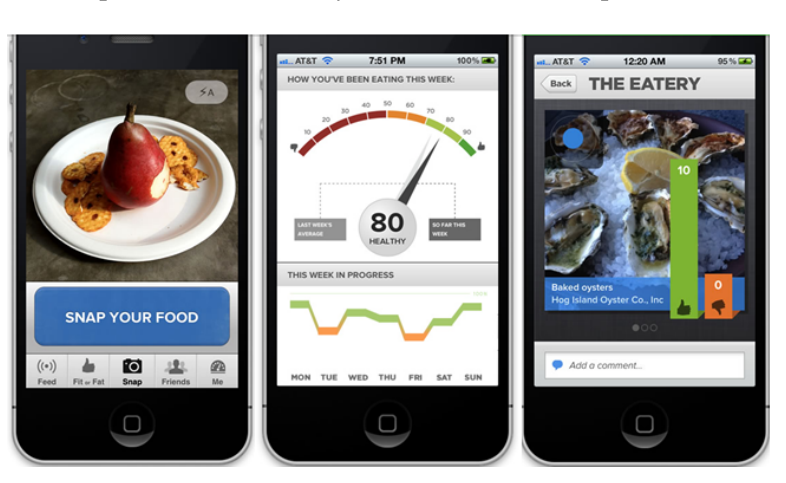
Figure 12. Infoviz Expectation: Intuitively-Understandable Graphics like in the Eatery